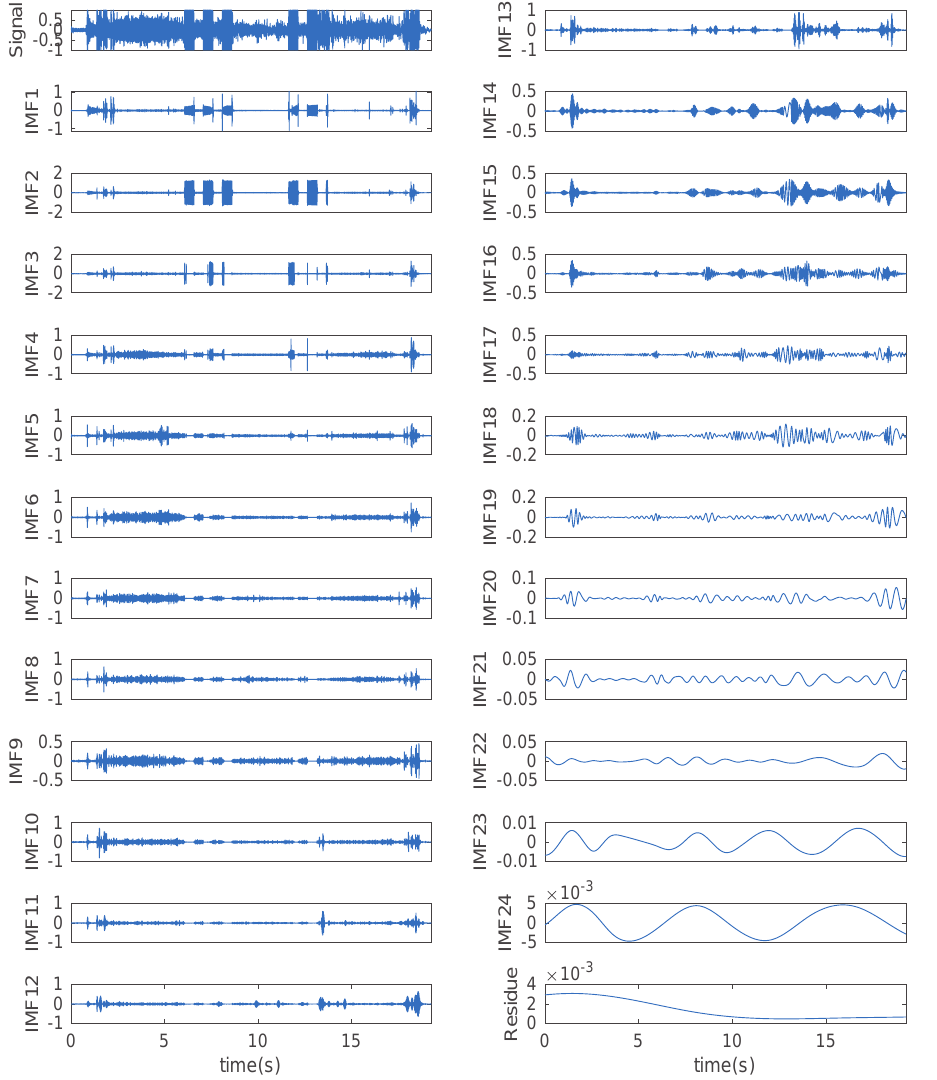
Figure 7. EMD results of a sound signal of